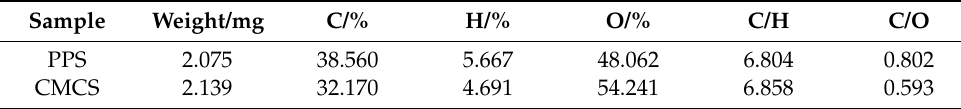
Table 1. Elemental analysis results of PPS and